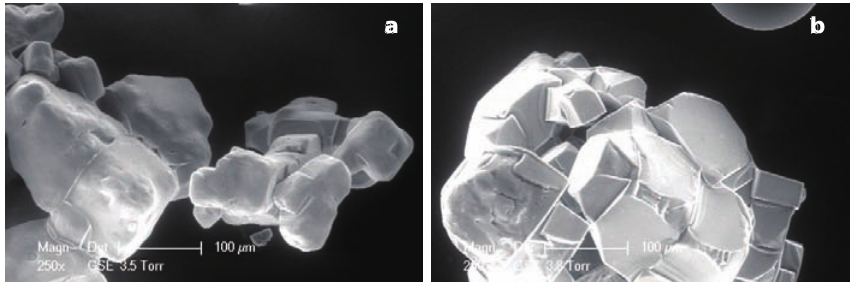
Fig. 9 Environmental scanning electron microscopy images of dry NaCl aggregates (a) before dissolution and (b) after recrystallization; size bar is 100 µ m in both